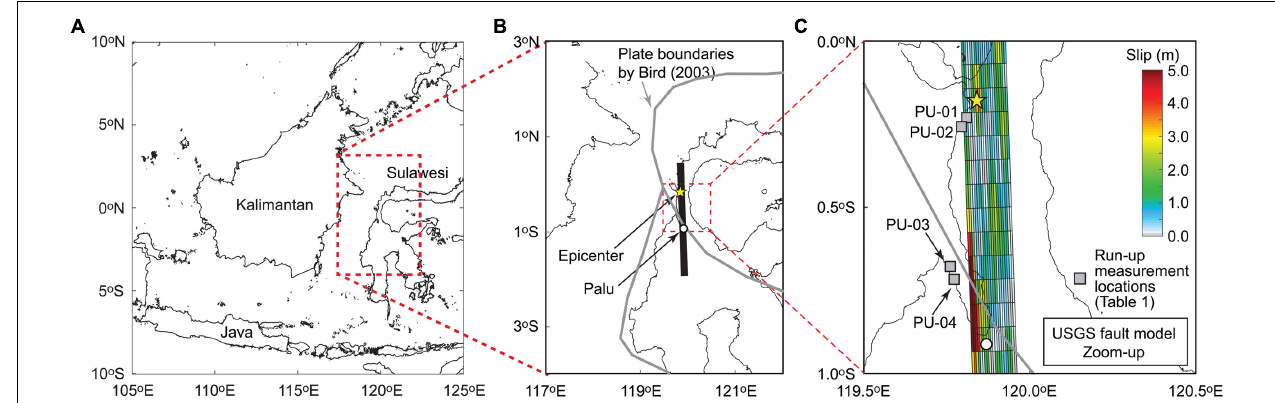
FIGURE 1 | (A) Map of Western Indonesia, (B) USGS model for the 2018 Sulawesi earthquake, and (C) zoom-up of the USGS model near Palu.